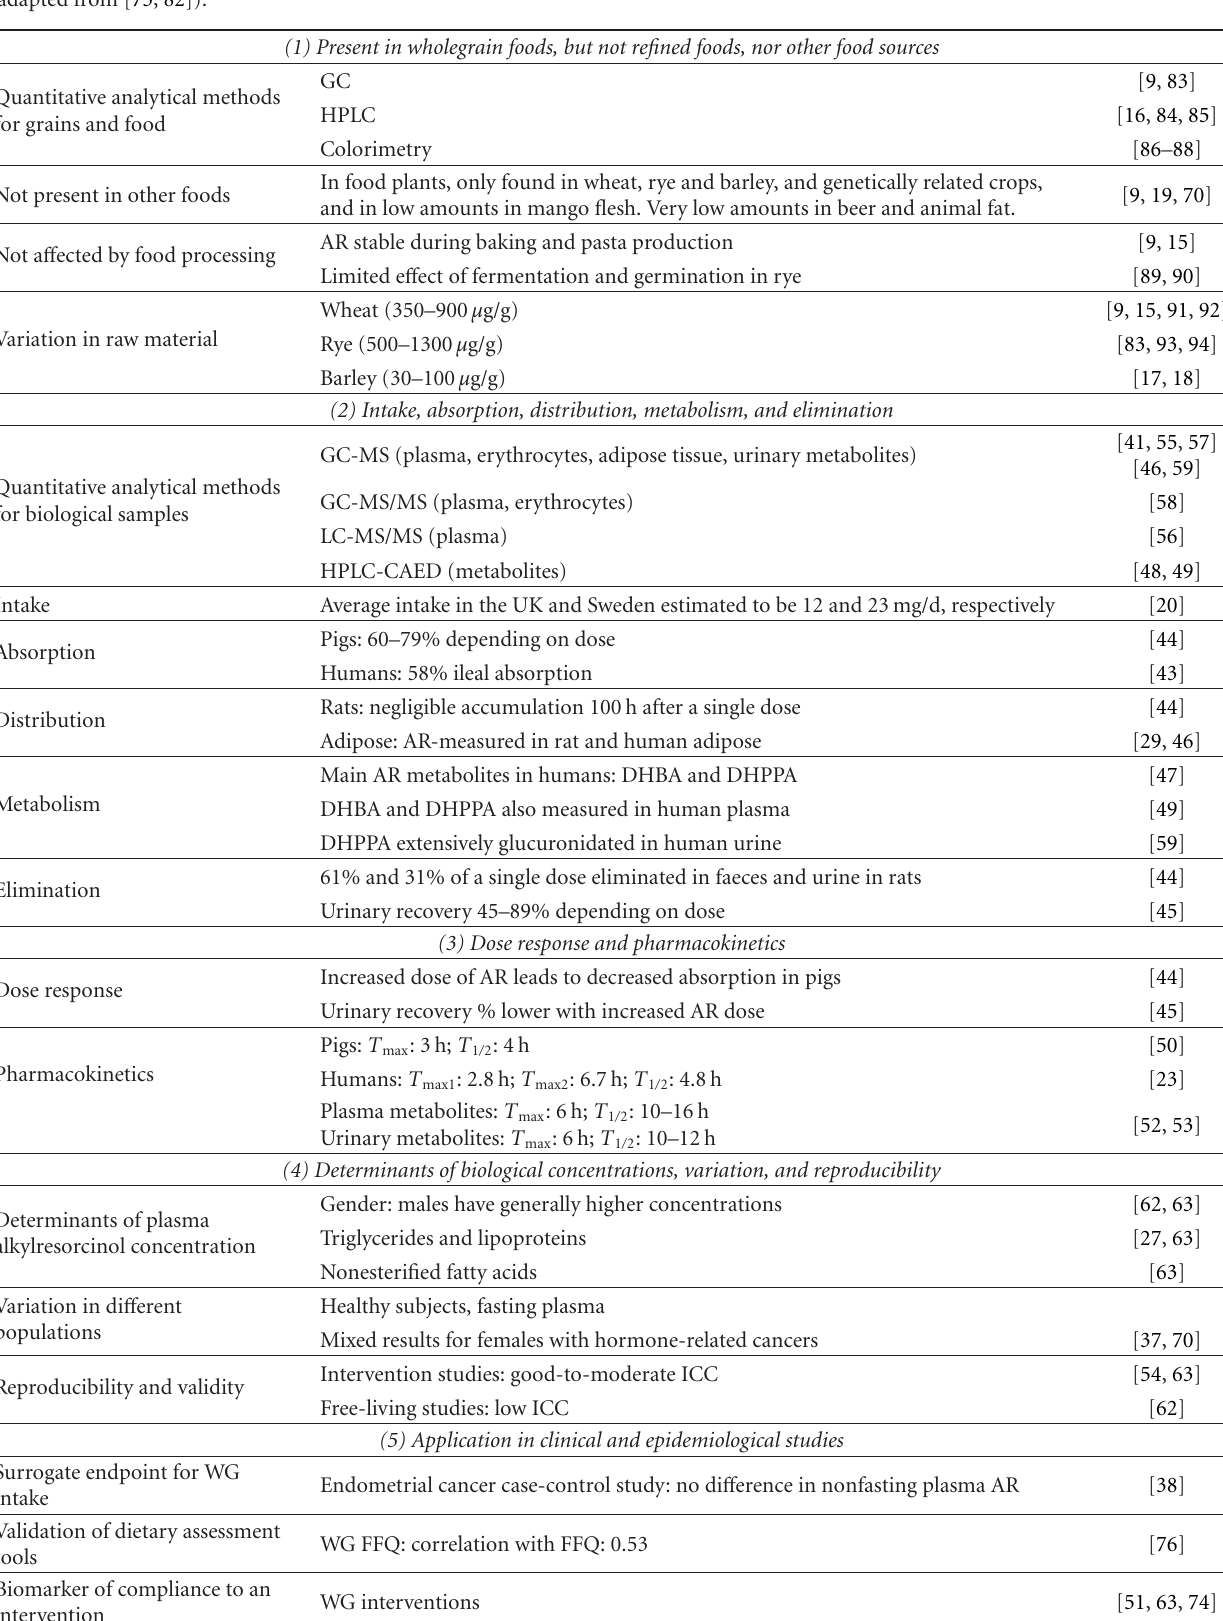
Table 1: Key steps for validating a biomarker, and if alkylresorcinols meet these criteria as biomarkers of alkylresorcinol containing foods (adapted from [75,